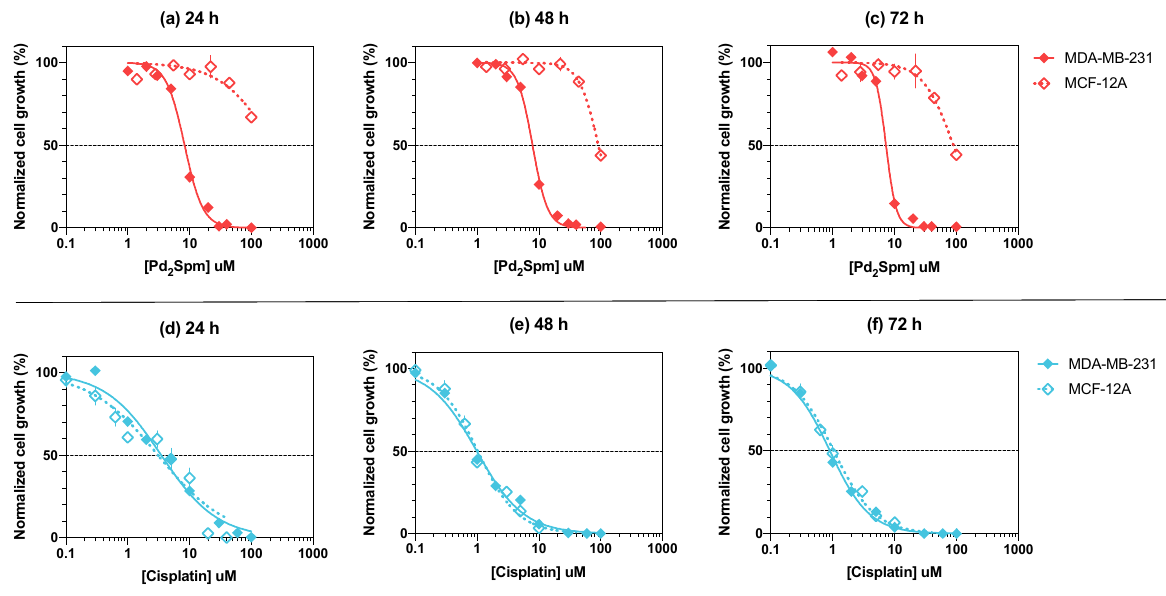
Figure 1. Dose–response curves of Pd 2 Spm (red, a – c ) and cisplatin (blue, d – f ) in breast cancer (MDA-MB-231, solid line) and non-cancer (MCF-12A, dotted line) cells at 24, 48 and 72 h of incubation. Data are expressed as mean ± SEM, n = 4. Data points with no visible error bars have errors smaller than the size of the symbol.